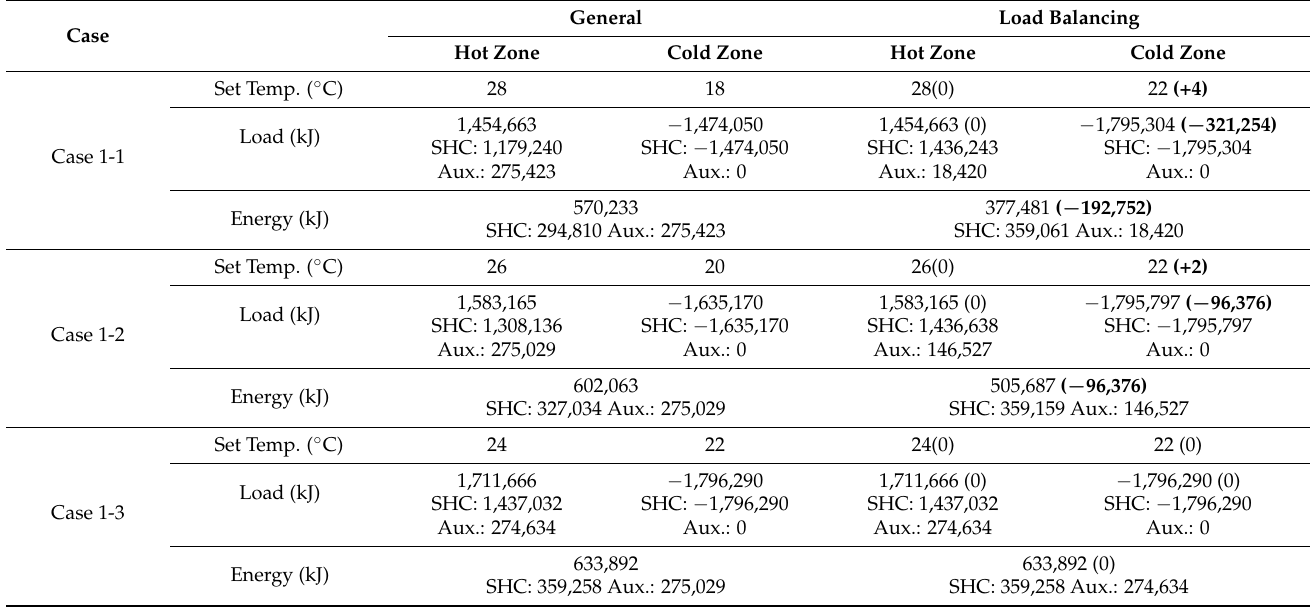
Table 6. Removed load and energy consumption (Cases 1 − 1~1 − 3).